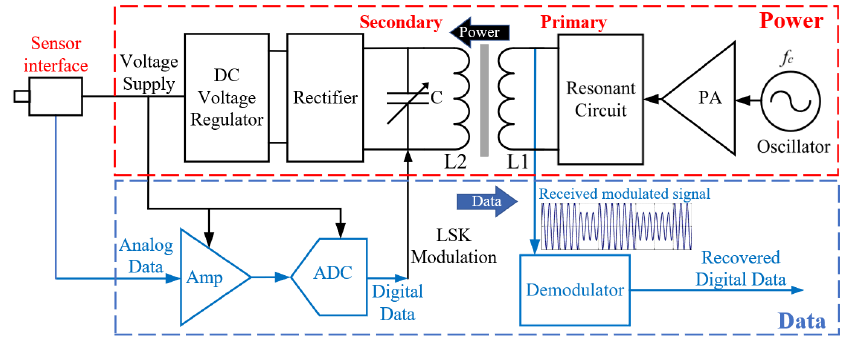
Figure 1. Block diagram of the proposed power and data transmission system.